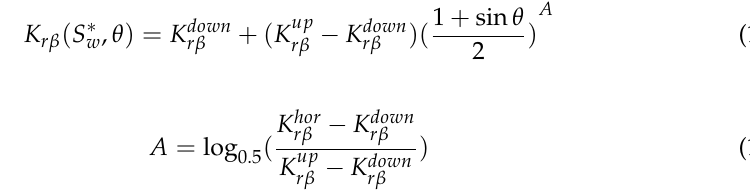
Figure 18. Upscaled relative permeability of the single-vug model at four different dimensionless water saturations in a polar coordinated system. Note that if the relative permeability is isotropic, then the points should be located on the same circle.